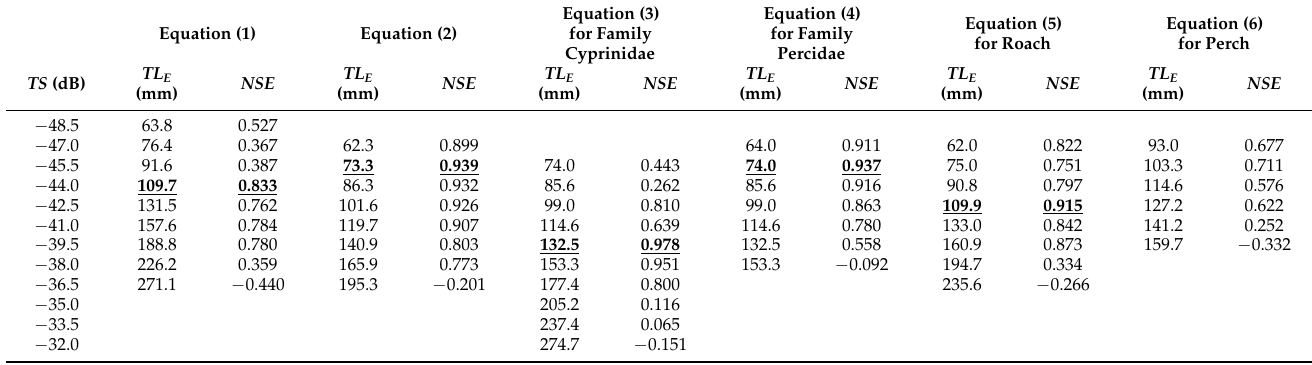
Table 3. Nash–Sutcliffe efficiency coefficient ( NSE ) for n -pairs of the relative share of fish caught with multi-mesh Nordic gillnets and hydroacoustic data in TS classes (with a range of 1.5 dB) determined on the basis of the TS – TL relationship according to Equations (1)–(6). Values in bold with an underline indicate the TS (and TL E ) threshold for which a best-fit linear regression can be